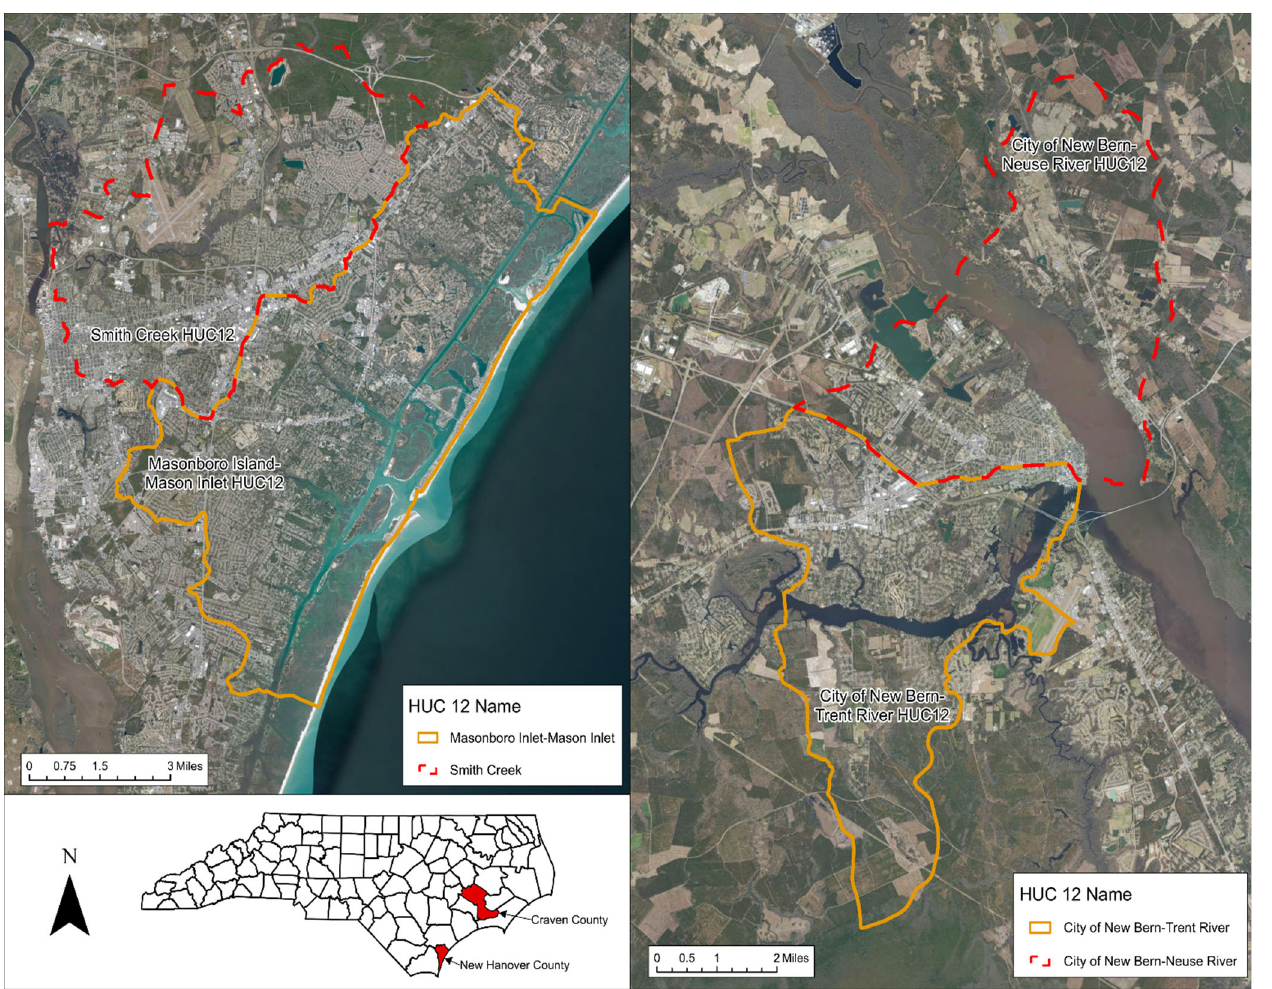
Table 1. Wetland vulnerability assessment datasets and sources.